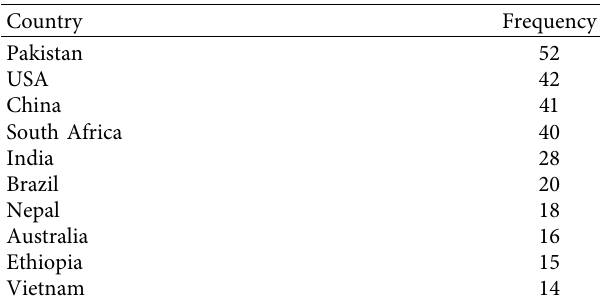
Figure 4: Accumulated journal dynamics of top 7 journals with highest publication number. Table 2: Top 10 countries’ scientific production on the GeneXpert in